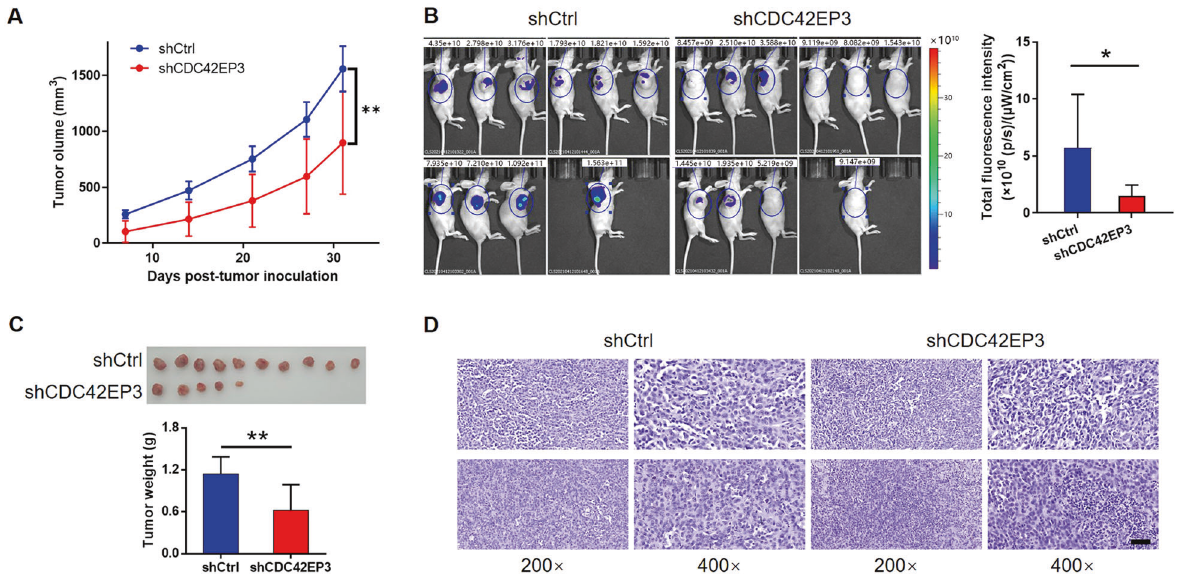
Fig. 3 CDC42EP3 depletion restricted in vivo tumor growth. A The comparison on the tumor volume after injecting shCtrl- and shCDC42EP3-harboring U251 cells into experimental animals. B The fl uorescence imaging and the difference on the total fl uorescence intensity of two experimental groups (shCtrl vs. shCDC42EP3) of mice. C The removed xenograft tumors and the difference in tumor weights between two groups (shCtrl vs. shCDC42EP3). D Representative images on the expression of Ki-67 derived from Ki-67 staining in the solid tumors. The scale bar is 50 µm long. Data were presented by mean with SD ( n ≥ 3). * P < 0.05, ** P <